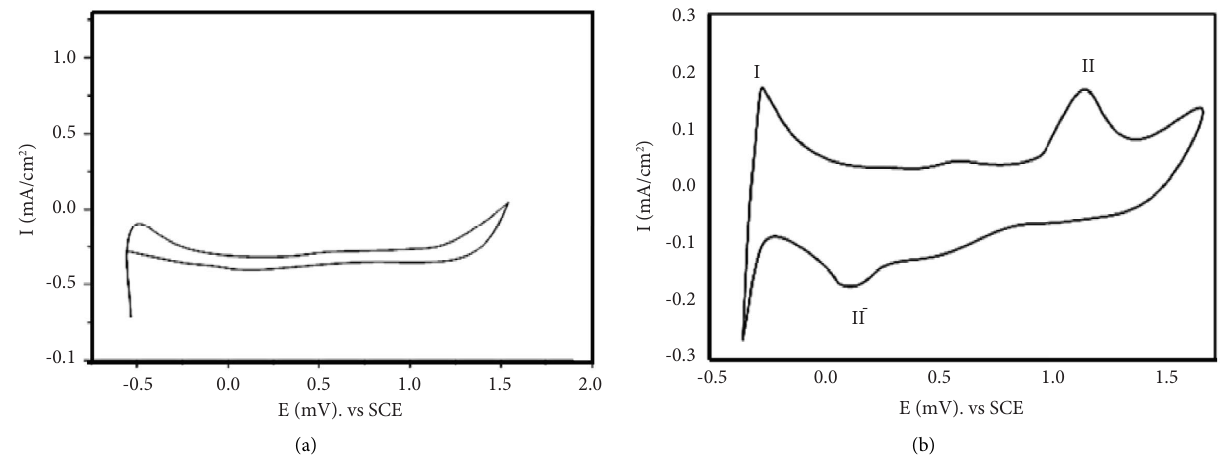
Figure 1: Cyclic voltammograms of a solution containing 0.30mol · L − 1 H (b) with 0.04 mol · L − 1